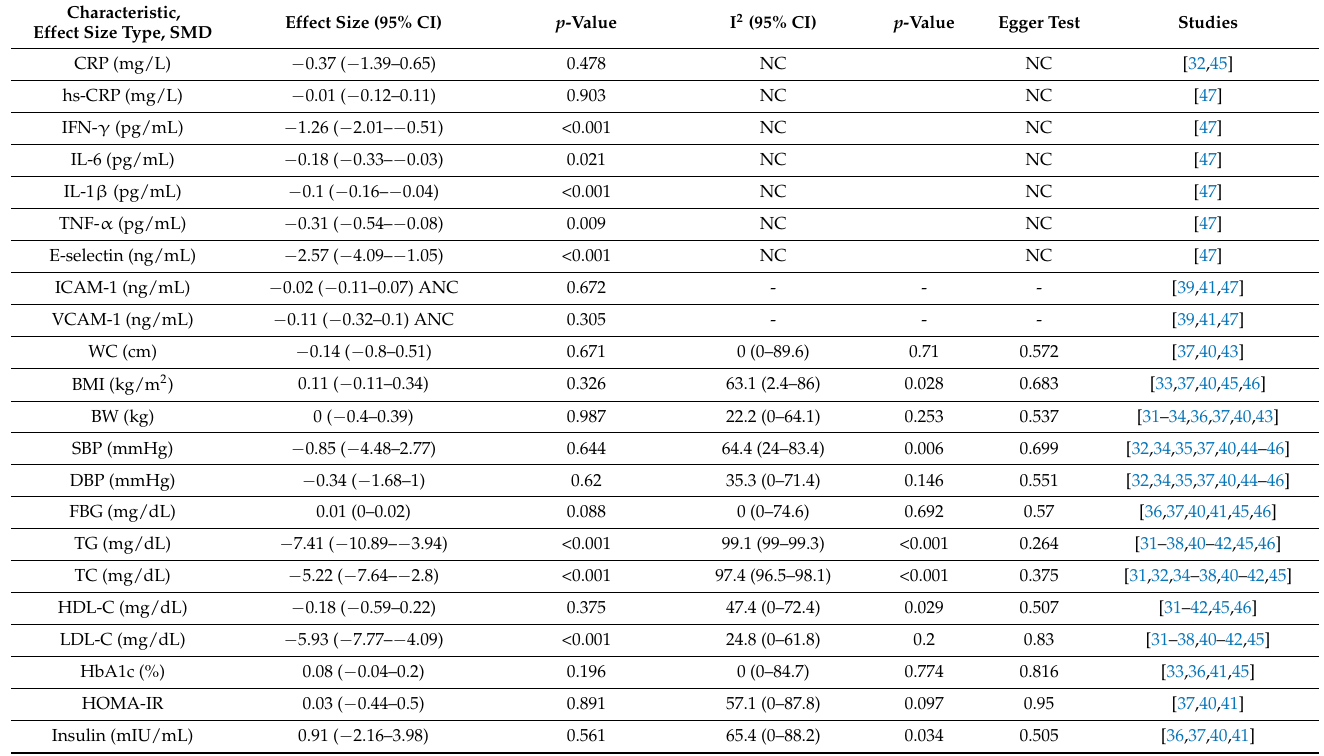
Table 2. Effects of walnut-enriched diets on inflammatory and metabolic syndrome